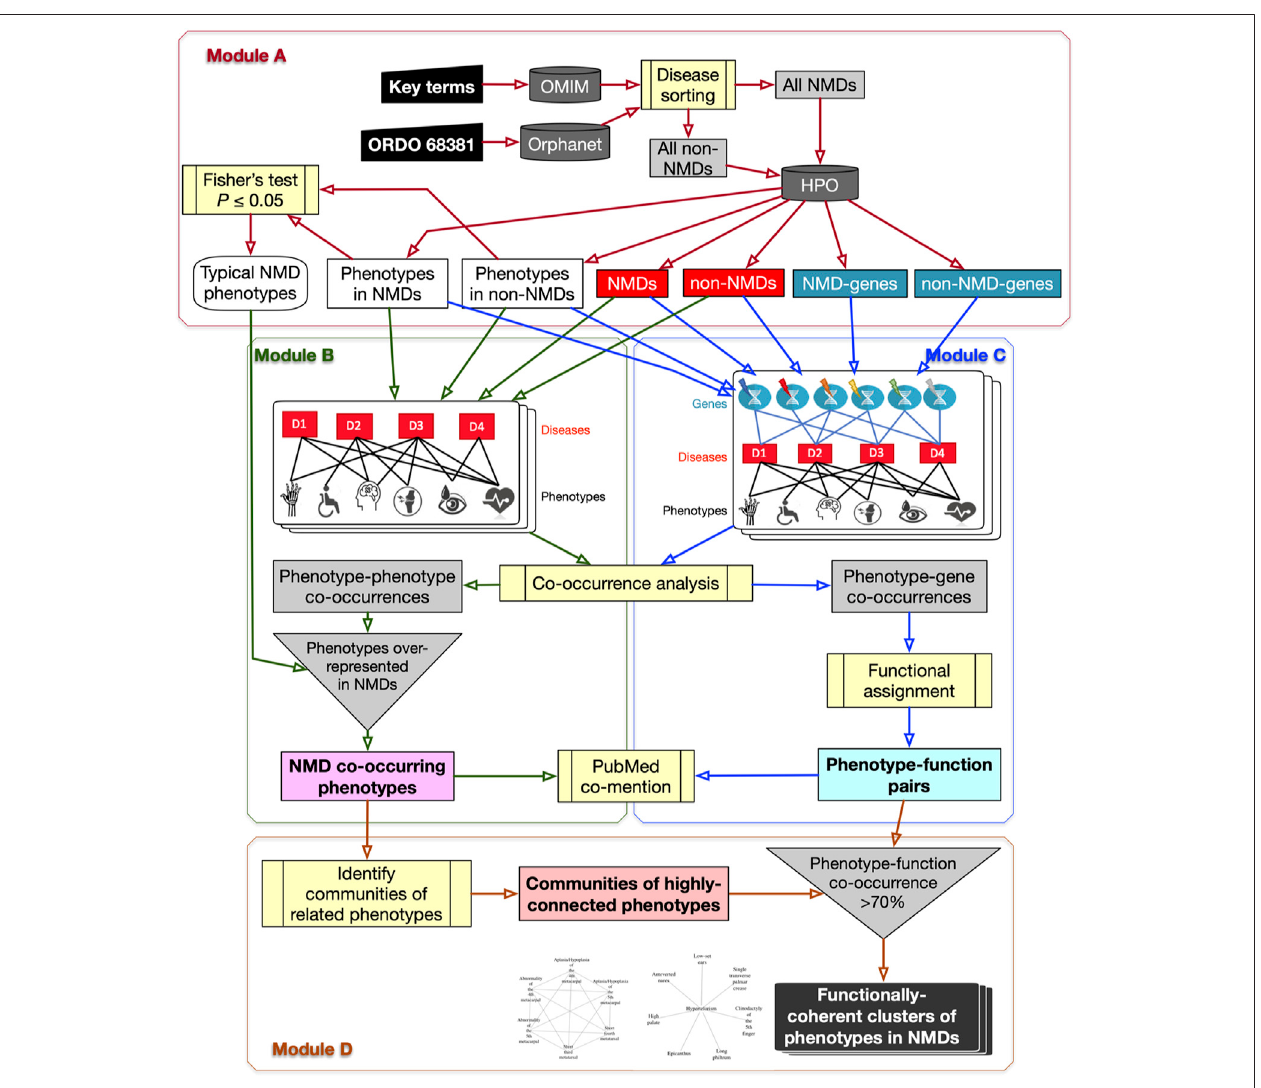
FIGURE 1 | Flowchart of the PhenoClusters work fl ow. Module (A) : all diseases in OMIM and Orphanet were classi fi ed as “ NMDs ” or “ non-NMDs ” . HPO is then queriedwiththosedisease,retainingonlythosediseases(redboxes)forwhichbothagene(tealboxes)andaphenotype(whiteboxes)areknown.Module (B) :abipartite networkwasconstructedandanalysedtoobtainthetypical “ NMDco-occurringphenotypes ” thattendedtooccurinNMDs.Module (C) :atripartitenetworkenabledthe obtentionofnew,signi fi cantphenotype-genepairsthatweretranslatedto “ phenotype-functionpairs ” .Module (D) :communitiesofhighlyrelatedphenotypeswere fi ltered based on shared function to obtain the fi nal set of “ functionally coherent clustersof phenotypes inNMDs ” . PubMed co-mention was used to assess the reliability oftheco-occurrence approach.Darkgreycylinders correspondtodatabases;yellowboxesarerelevantanalyses;inverted trianglesindicateprocessmerging;lightgrey rectangles are intermediate sets of results; coloured rectangles with text in bold mark relevant